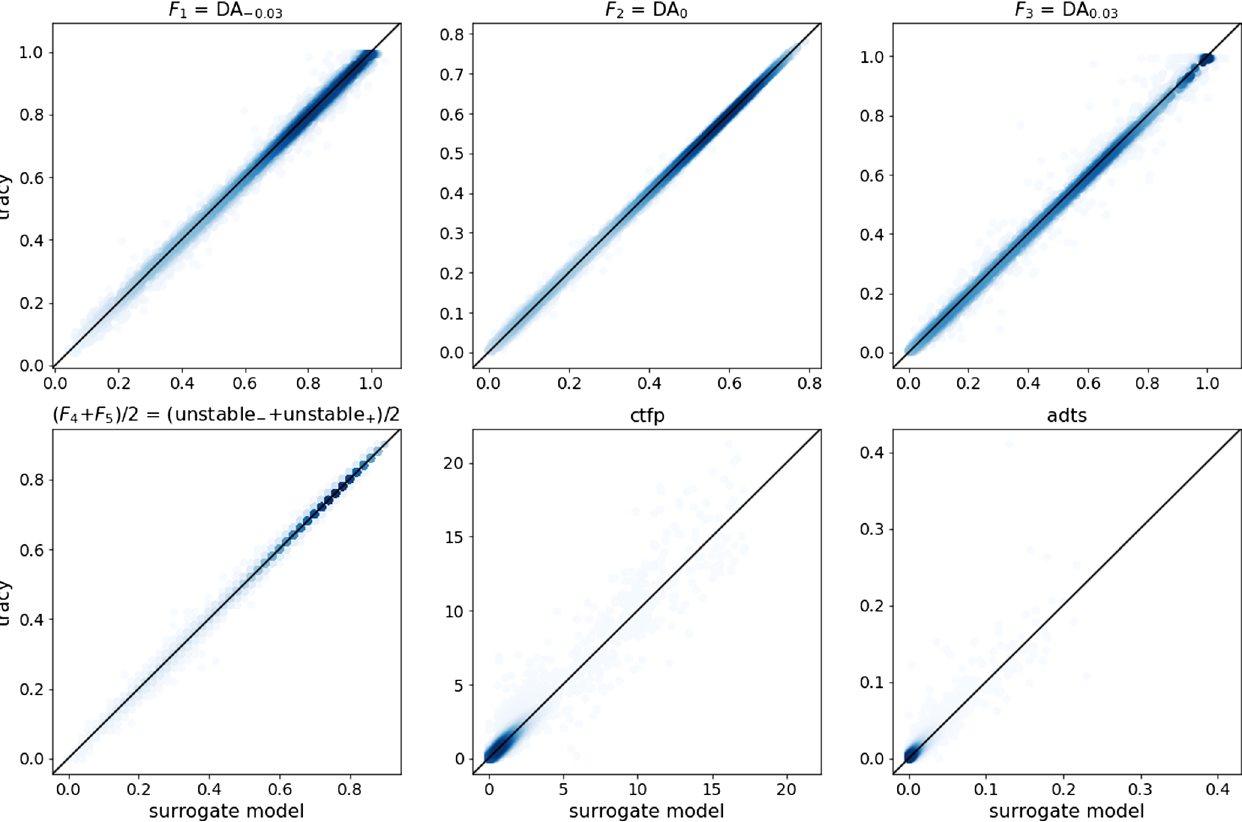
FIG. 3. The surrogate model quality on the test set, i.e., random design points that were not used for training. The surrogate model was trained using a training set of size 2 . 1 × 10 4 and a validation set of size 6000. Its quality is tested on a test set of size 3000. In each subplot the x and y coordinates are the values computed with the surrogate model and TRACY , respectively (a point on the line y ¼ x would be perfect agreement). Darker blue colors represent higher design point